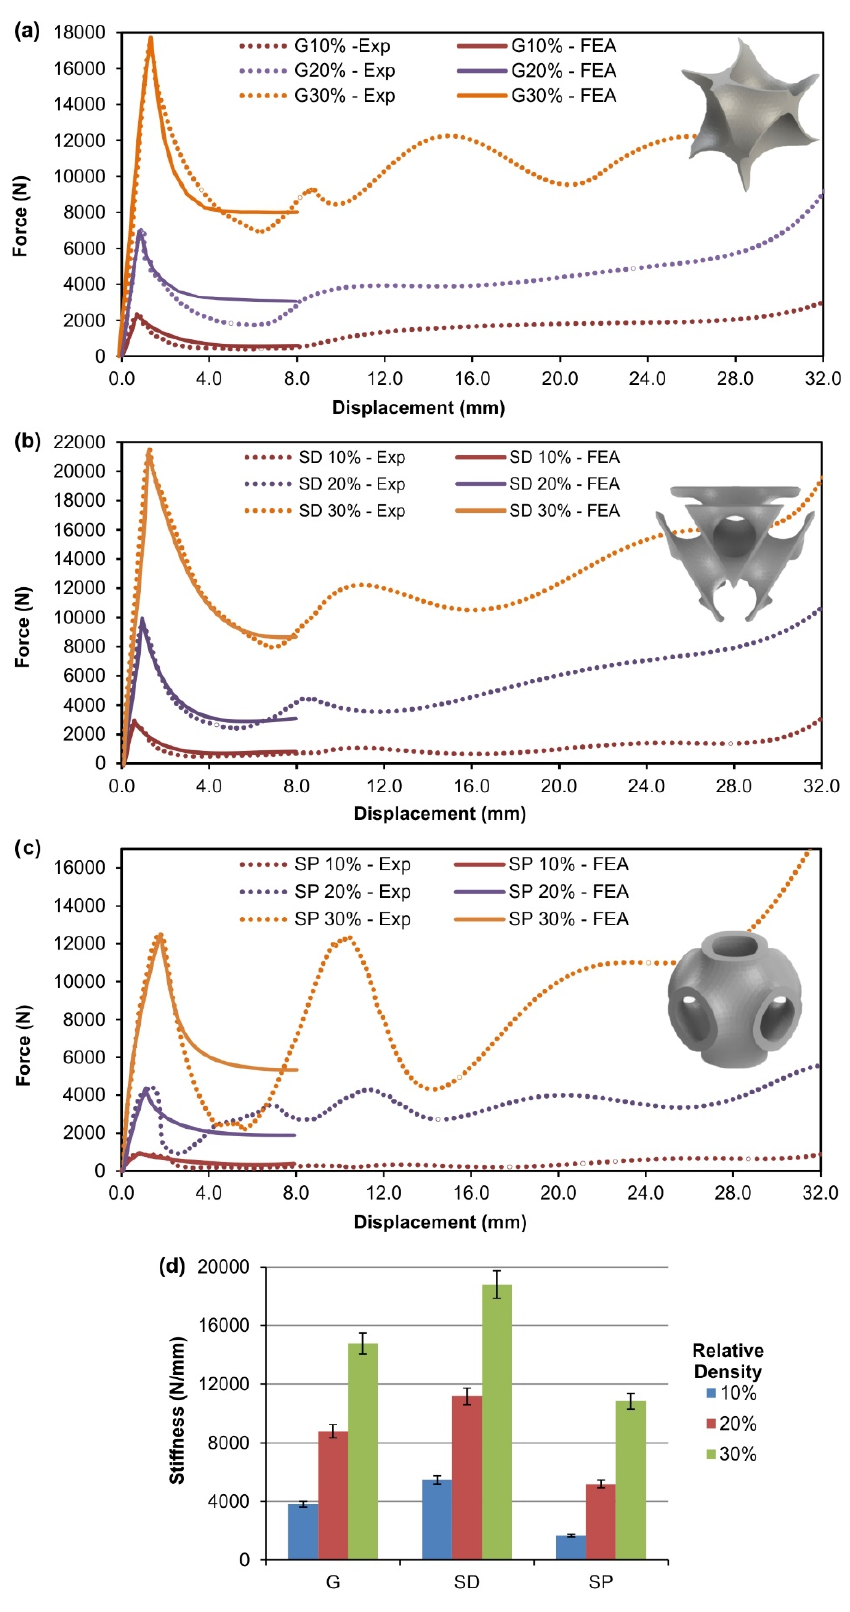
Figure 7. Comparison between finite element analysis (FEA)-determined and experimental compression tests for: ( a ) Gyroid, ( b ) SD, ( c ) SP TPMS structures and ( d ) a bar chart of the stiffness values for all the TPMS structures.